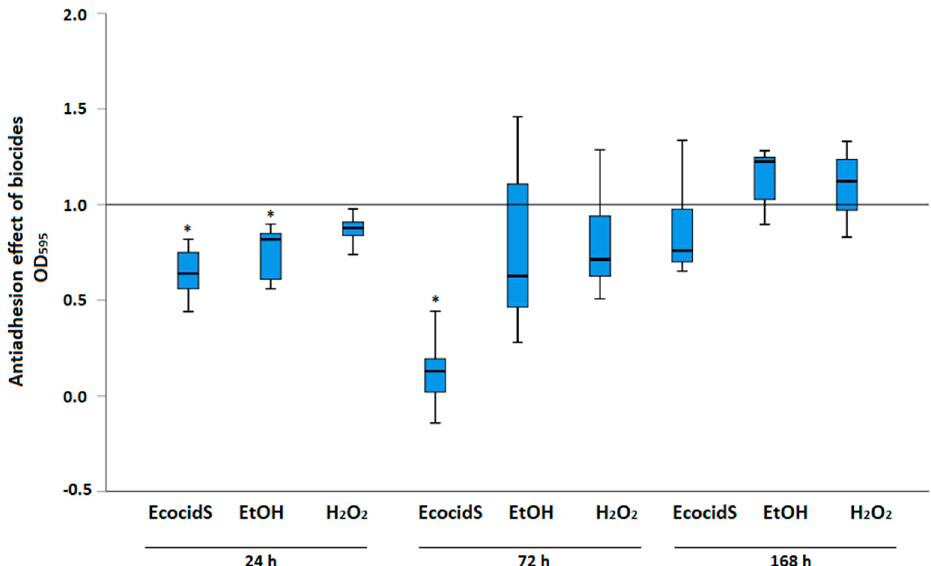
Figure 2. Antiadhesion effect of disinfectants on S. Infantis 323/19 strain after different incubation